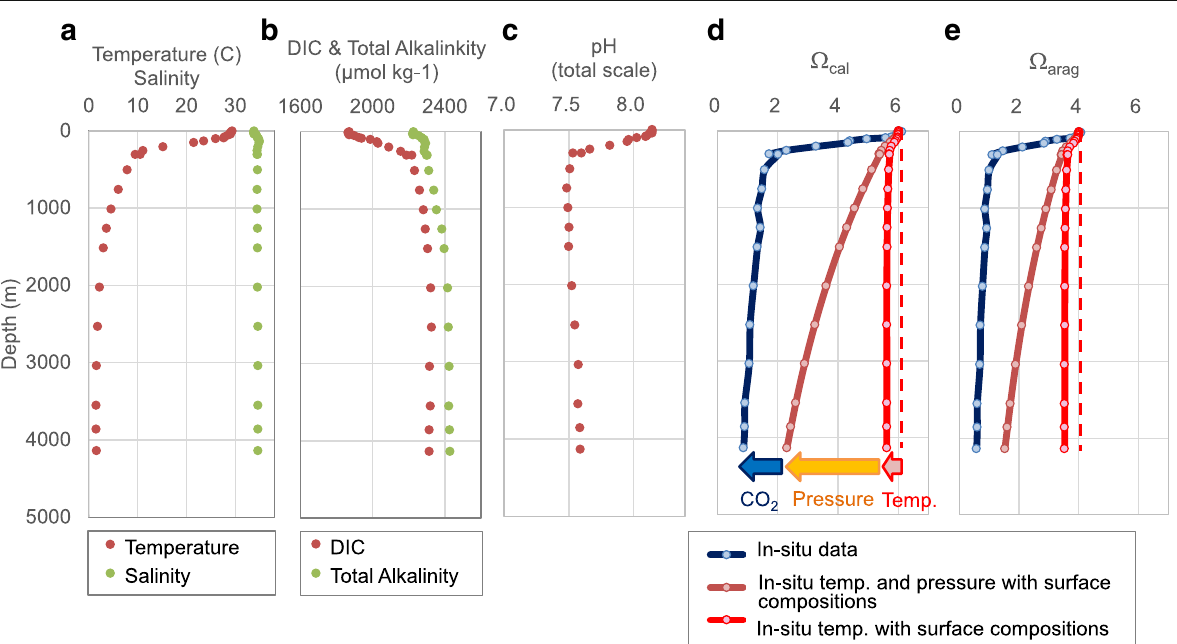
Fig. 4 Depth profiles of temperature and salinity ( a ), total alkalinity and DIC ( b ), pH and total hydrogen concentration scale ( c ), and saturation states for calcite ( Ω cal ; d ), and aragonite ( Ω arag ; e ) at St. 96 (5° 00 ′ N, 144° 55.7 ′ E; water depth 4102 m; sampling date April 22, 1995) in the tropical western Pacific during the NOPACCS NH95-1 cruise (data were downloaded from http://pacifica.pices.jp/table/). The compositions of the surface water include a temperature of 29.4 °C, salinity of 33.859, DIC of 1870 μ mol kg − 1 , and total alkalinity of 2225 μ mol kg − 1 . The chemical equilibrium calculation was conducted using CO2calc (Robbins et al. 2010) to elucidate temperature and pressure influences on changes in the depth profiles of Ω cal and Ω arag . Note that changes in CO 2 system chemistry are responsible for rapid decreases in Ω cal and Ω arag below the surface layer, whereas pressure influence becomes dominant at greater depth. Ksp is much dependent on the pressure: K sp for calcite = (1.95 – 0.0176×T)10 − 2 ×S×10 ((0.693 – – 0.0217×T)10 − 2 ×S×10 ((0.650 – 0066×T)10 – 0.00645×T)10 – 4×z) ; K sp for aragonite = (3.06